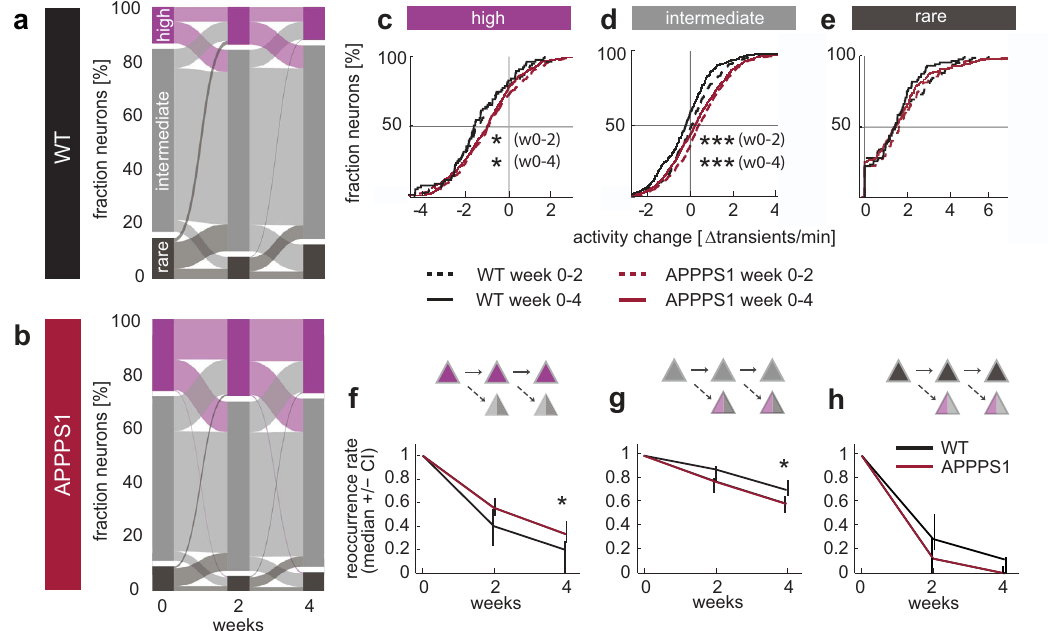
Fig. 4 Category-speci fi c changes in neuronal activity. a , b Alluvial plots depicting the fractional change between time points of highly (>4 transients/min), intermediately (0.25 – 4 transients/min) and rarely active (<0.25 transients/min) neurons in WT ( a ) and APPPS1 ( b ) mice over time (fraction highly active neurons: week 0 – 4 effect of group: F 1,72 = 6.96, p = 0.012, effect of time: F 2,72 = 0.15, p = 0.86, group-by-time interaction effect: F 2,72 = 0.83, p =